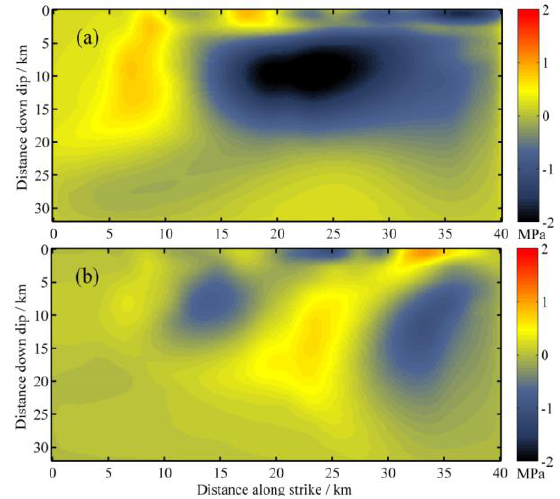
Figure 4. (a) Strike-parallel component of static stress change; (b) Up-dip component of static stress change.